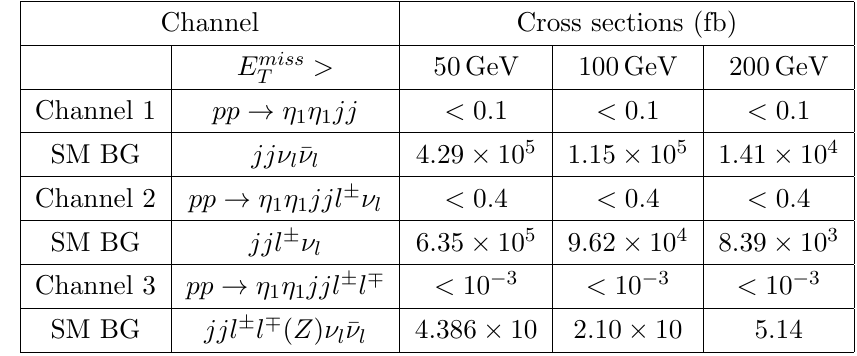
Cross section for the three chosen channels with di(cid:11)erent E miss main irreducible backgrounds (SM BG) are also